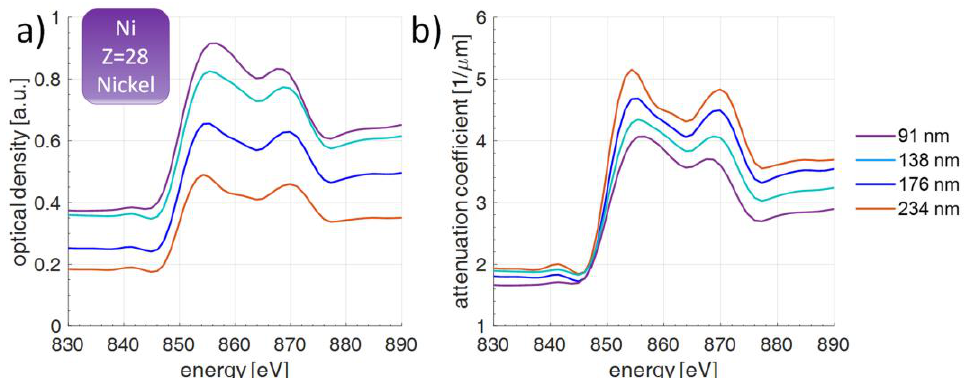
Figure 4. Optical density ( a ) and attenuation coefficient ( b ) spectra in the photon energy range from 830 eV to 880 eV for thin layers of Ni of various thicknesses, deposited on top of 100 nm thick SiN membrane. The presented spectra are obtained using data filtering by the Golay–Savitzky 3 × 11 filter.